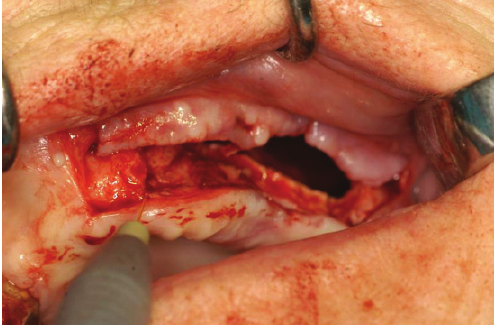
Figure 5: Intraoperatory biostimulation (Step 3): before suturing, Nd:YAG laser biostimulation was performed with a 320 microme- ters fiber for 5 applications of 1 minute each.